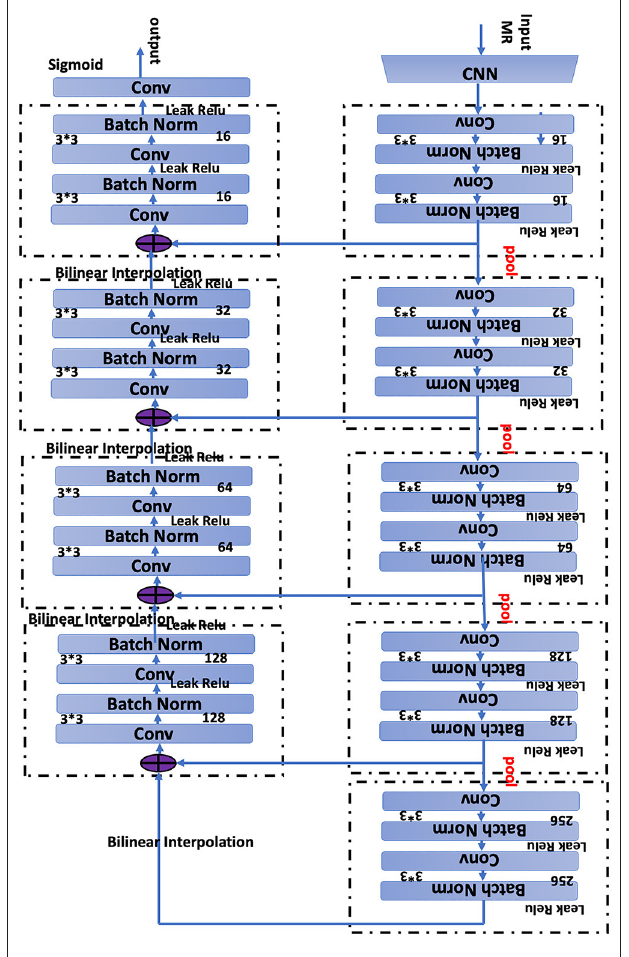
FIGURE 3 | Network architecture of the proposed two-dimensional (2D) convolutional neural network (CNN). The network has 19 layers integrating nine Convolution blocks. Bilinear interpolating arrows indicate up sampling operations to make predictions for the segmentation task. The pool arrow indicates the down sampling operation to gradually increasing the receptive field for the segmentation task. Concatenate connections are used to fuse Multi-scale features in the network. Batch normalization is a linear transformation of the features performed to reduce the covariance shift, thus speeding up the training procedure. Convolution bars indicate the convolution operation, which computes the features. The number 16, 32, 64, 128, 256 indicates the number of channels in that layer, and 3 · 3 · 3 · 3 · 3 · 3 denotes the size of the 2D CNN kernels.